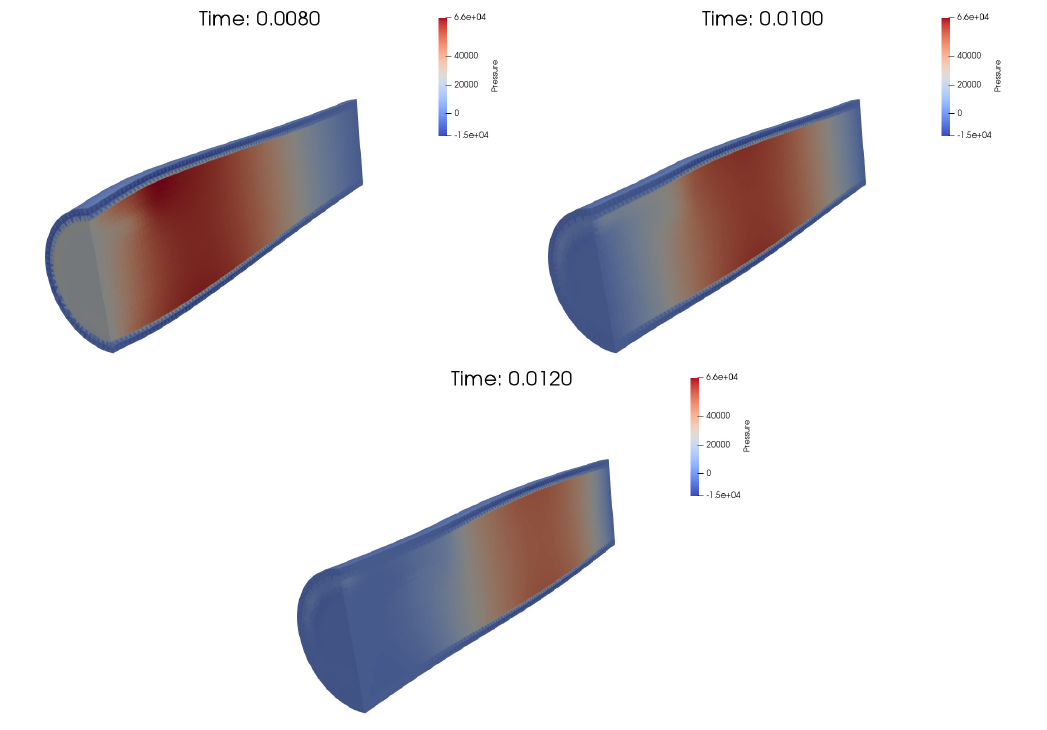
Figure 4. The pressure obtained with Mesh 4 using sin-like stress at the